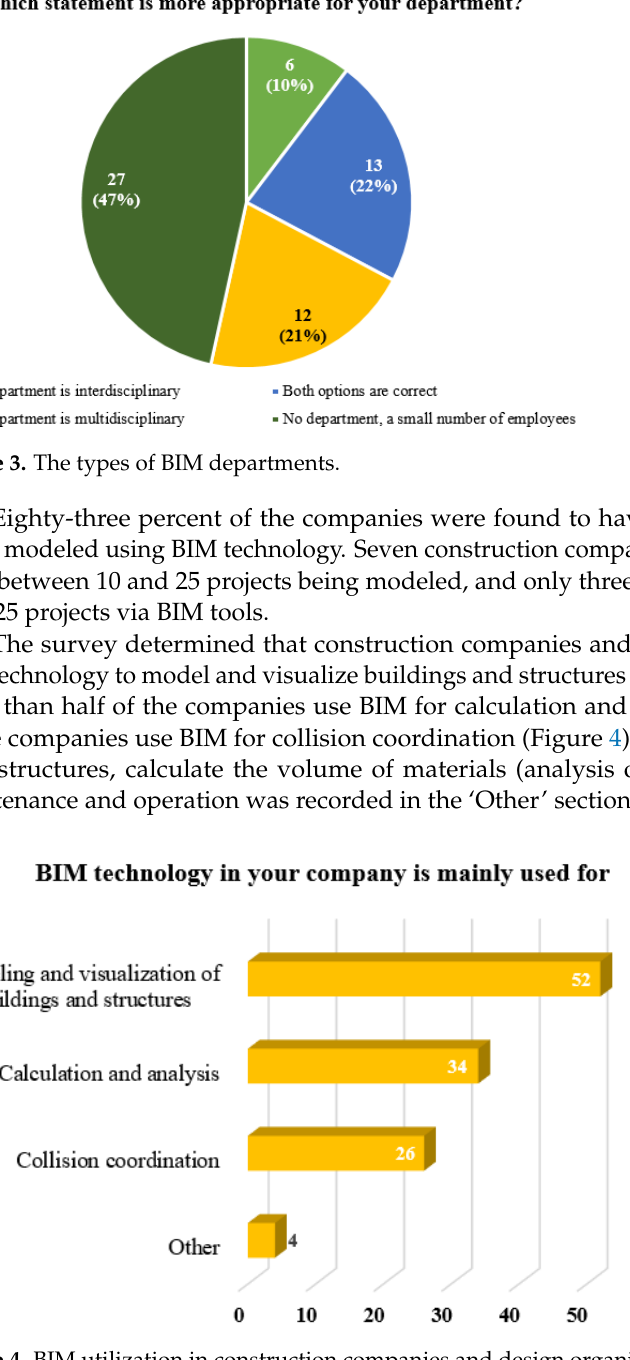
Figure 4. BIM utilization in construction companies and design organizations.